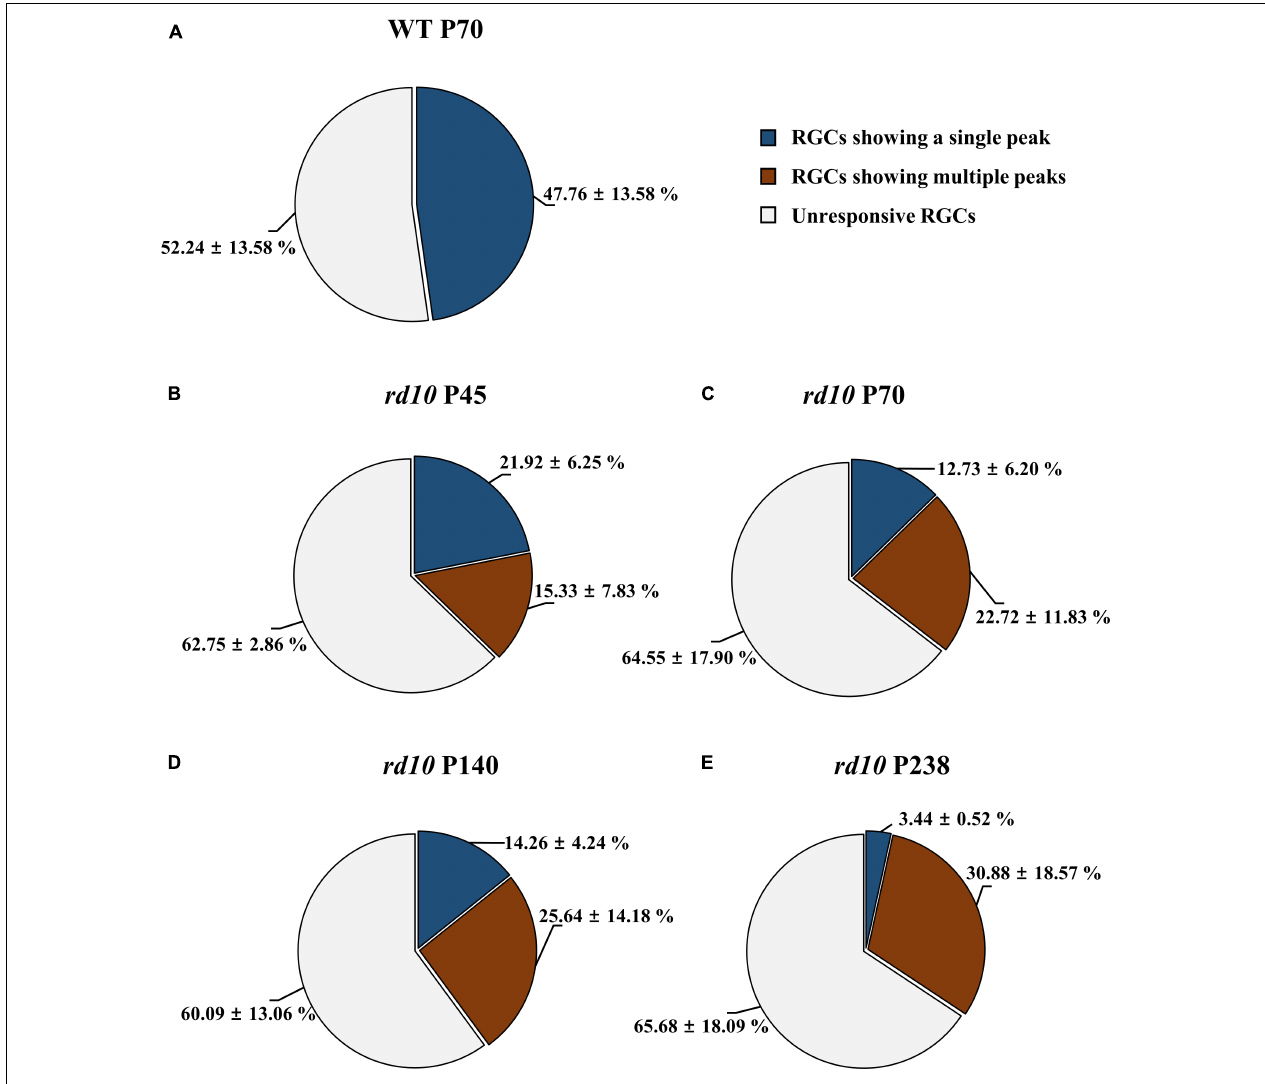
FIGURE 6 | The difference in the ratio of retinal ganglion cells (RGCs) showing multiple peaks among ER-RGCs according to postnatal ages. The ratio of RGCs showing the single peak (blue portion) and multiple peaks (red portions) was calculated in the wild-type (WT) group at P70 (A) and rd10 groups at P45 (B) , P70 (C) , P140 (D) , and P238 (E) . The statistics value represents the mean ± standard deviation (SD).